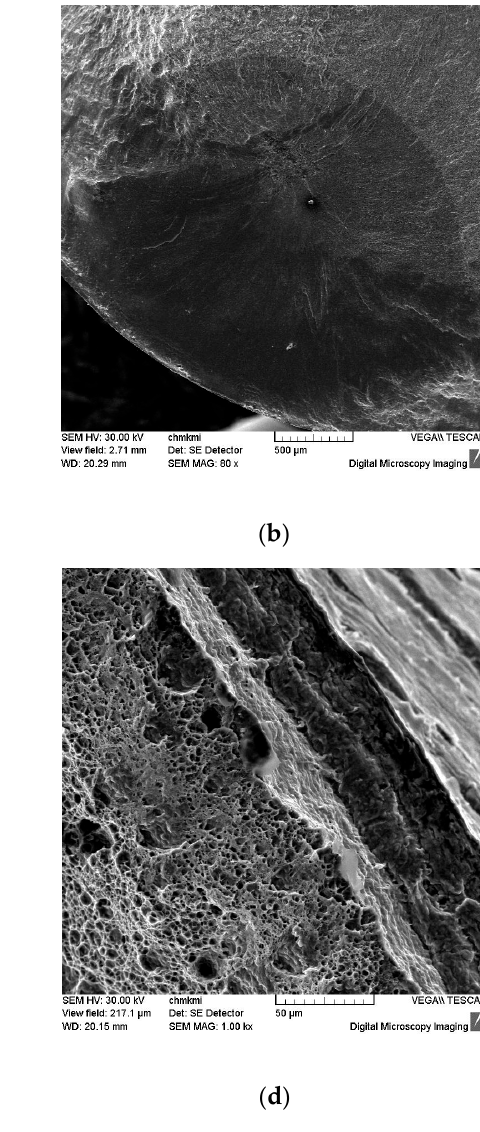
Figure 15. Fracture surface of UIP 135 N Strenx 700 MC specimen loaded at 410 MPa and fractured after 4.0 × 10 5 cycles: Overall view of the fracture ( a ), detail of fish-eye fatigue crack initiation ( b ), ductile delamination of the strengthened surface layer ( c ) and final fracture with area of finer dimples in the strengthened surface layer ( d ).